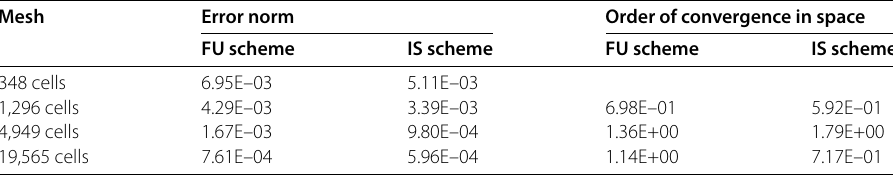
Table 3 Computed error norms and the order of convergence for Test 3 Mesh Error norm Order of convergence in space FU scheme IS scheme FU scheme IS scheme 348